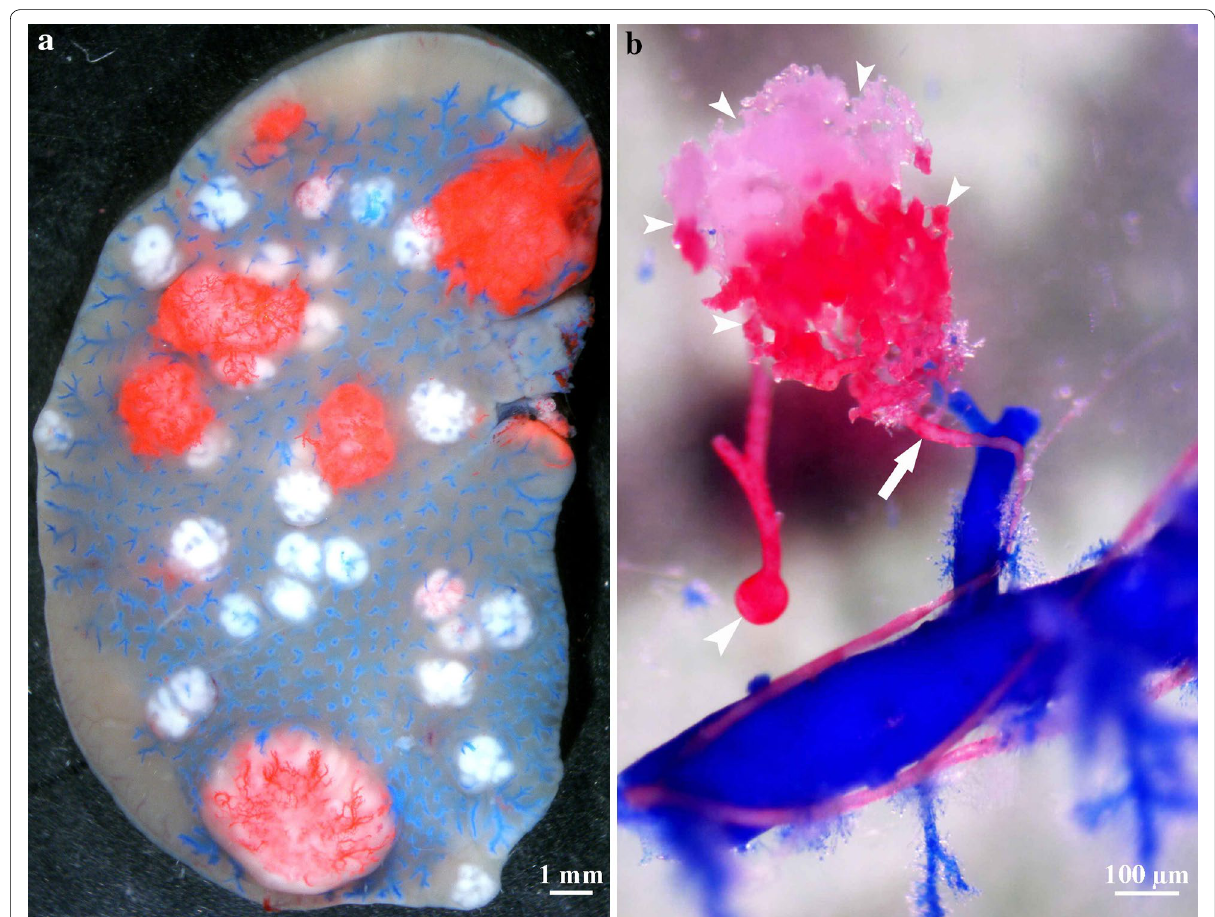
Fig. 4 Blood supply of liver metastases. a Stereomicroscopic image of colorectal carcinoma liver metastases after two colored casting procedure. Blue resin was injected into the portal vein and red resin was injected into the arterial system. Smaller metastases supplied by the portal system appear white (since the portal system was filled up to the level of terminal portal venules, the resin does not enter the sinusoids and, consequently, it does not enter the small metastases). Red resin appears in metastases that are in direct connection with the arterial system. Note that all of these metastases are larger than those that appear white. Scale bar 1 mm. b An arterial metastasis after corrosion of liver tissue. The artery ( red ) runs next to the portal venule ( blue ) and enters the metastasis ( small arrowheads ) centrally ( arrow ). Moderate dilatation of the artery can be observed near the entry site ( arrow ). The red resin injected into the arterial system appears also in the central vein ( large arrowhead ). Scale bar 100